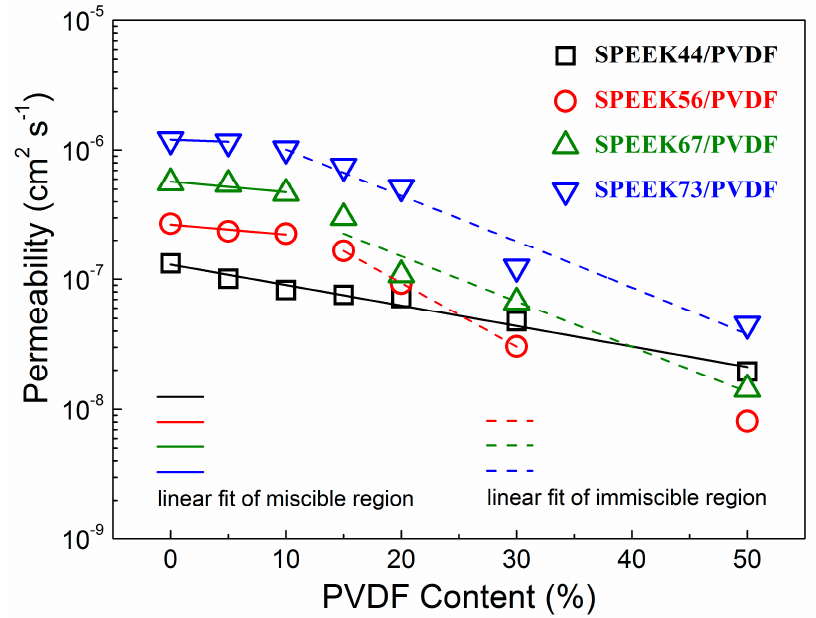
Figure 6. Methanol permeability as a function of PVDF content for SPEEK/PVDF blend membranes.